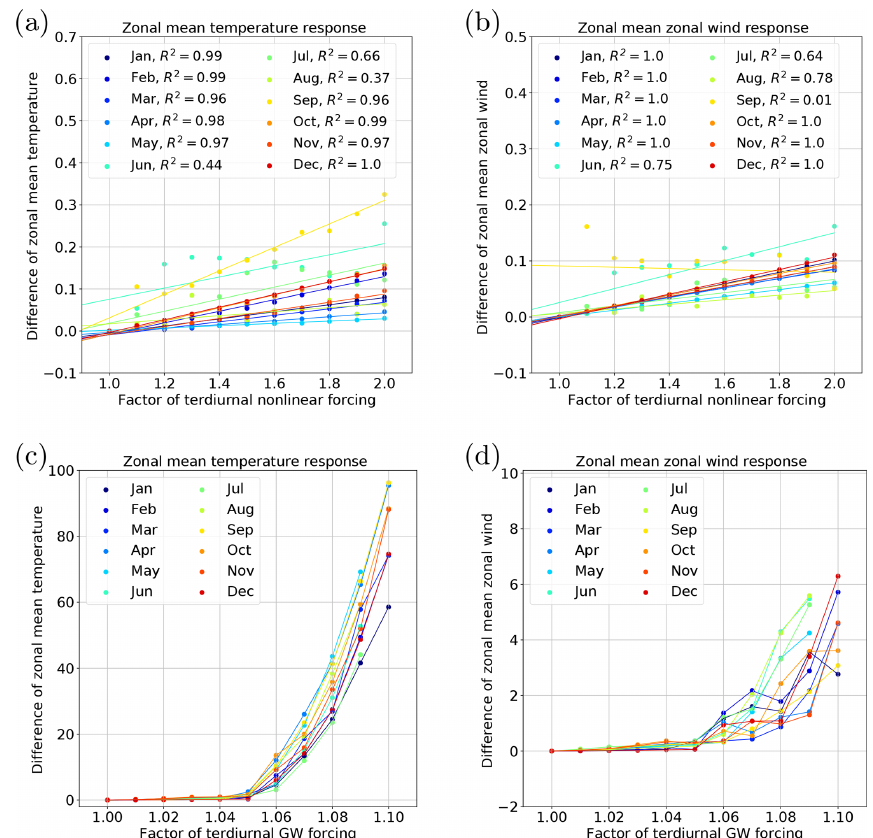
Figure 6. Horizontal mean vertical mean (80–160km height range) absolute change of zonal mean temperature (a, c) and zonal wind (b, d) according to an increased terdiurnal forcing in NLIN 2000 (a, b) and GWF 2000 (c, d) . The factor of the increased nonlinear (a, b) and GW forcing (c, d) is indicated on the abscissa. Units of the ordinate are meters per second (ms − 1 ) and Kelvin (K), respectively. For the enhancement of the nonlinear forcing (a, b) , a linear fit is added for each month (corresponding correlation coefficients R 2 : see